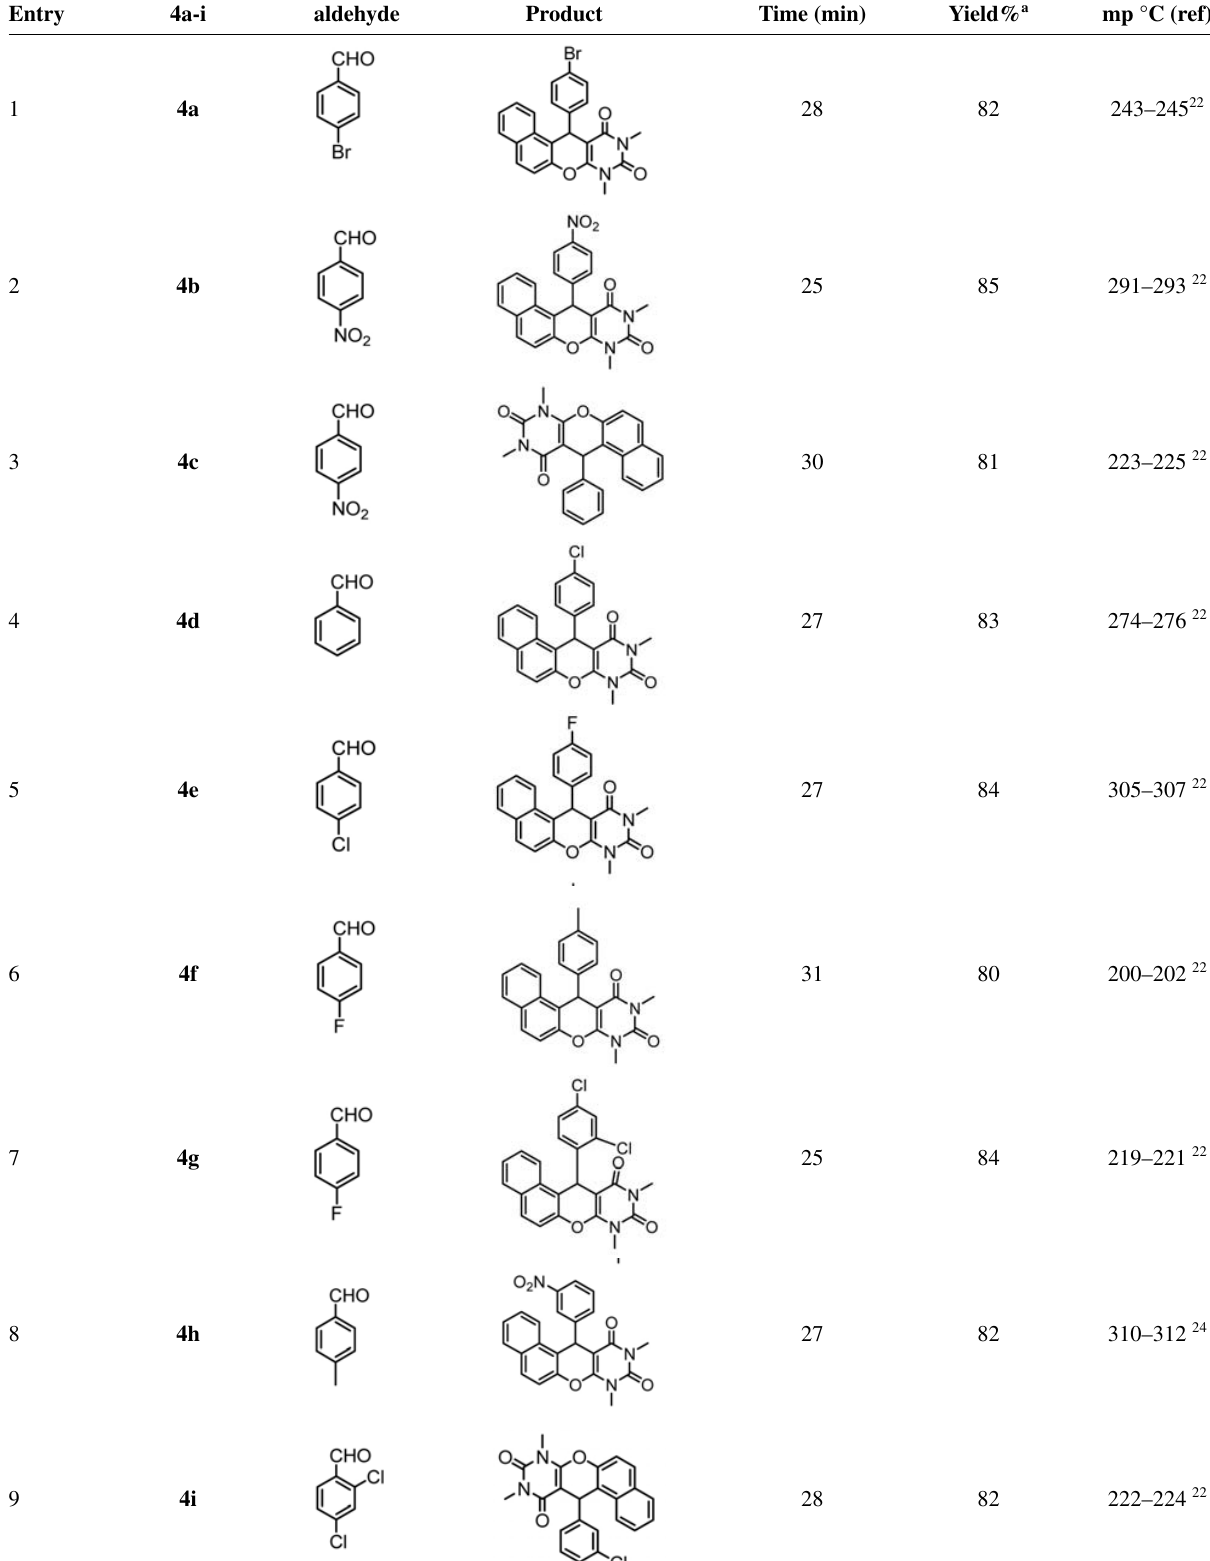
/nano-TiO under solvent-free conditions at 100 ° 2 2